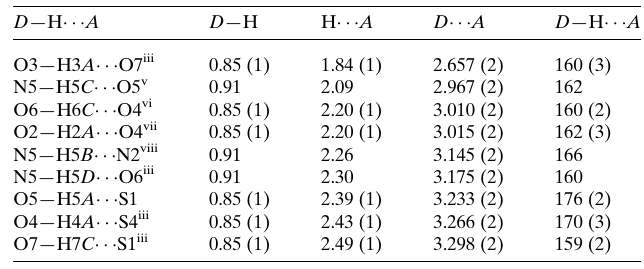
Table 1 Selected bond lengths (A˚ ).